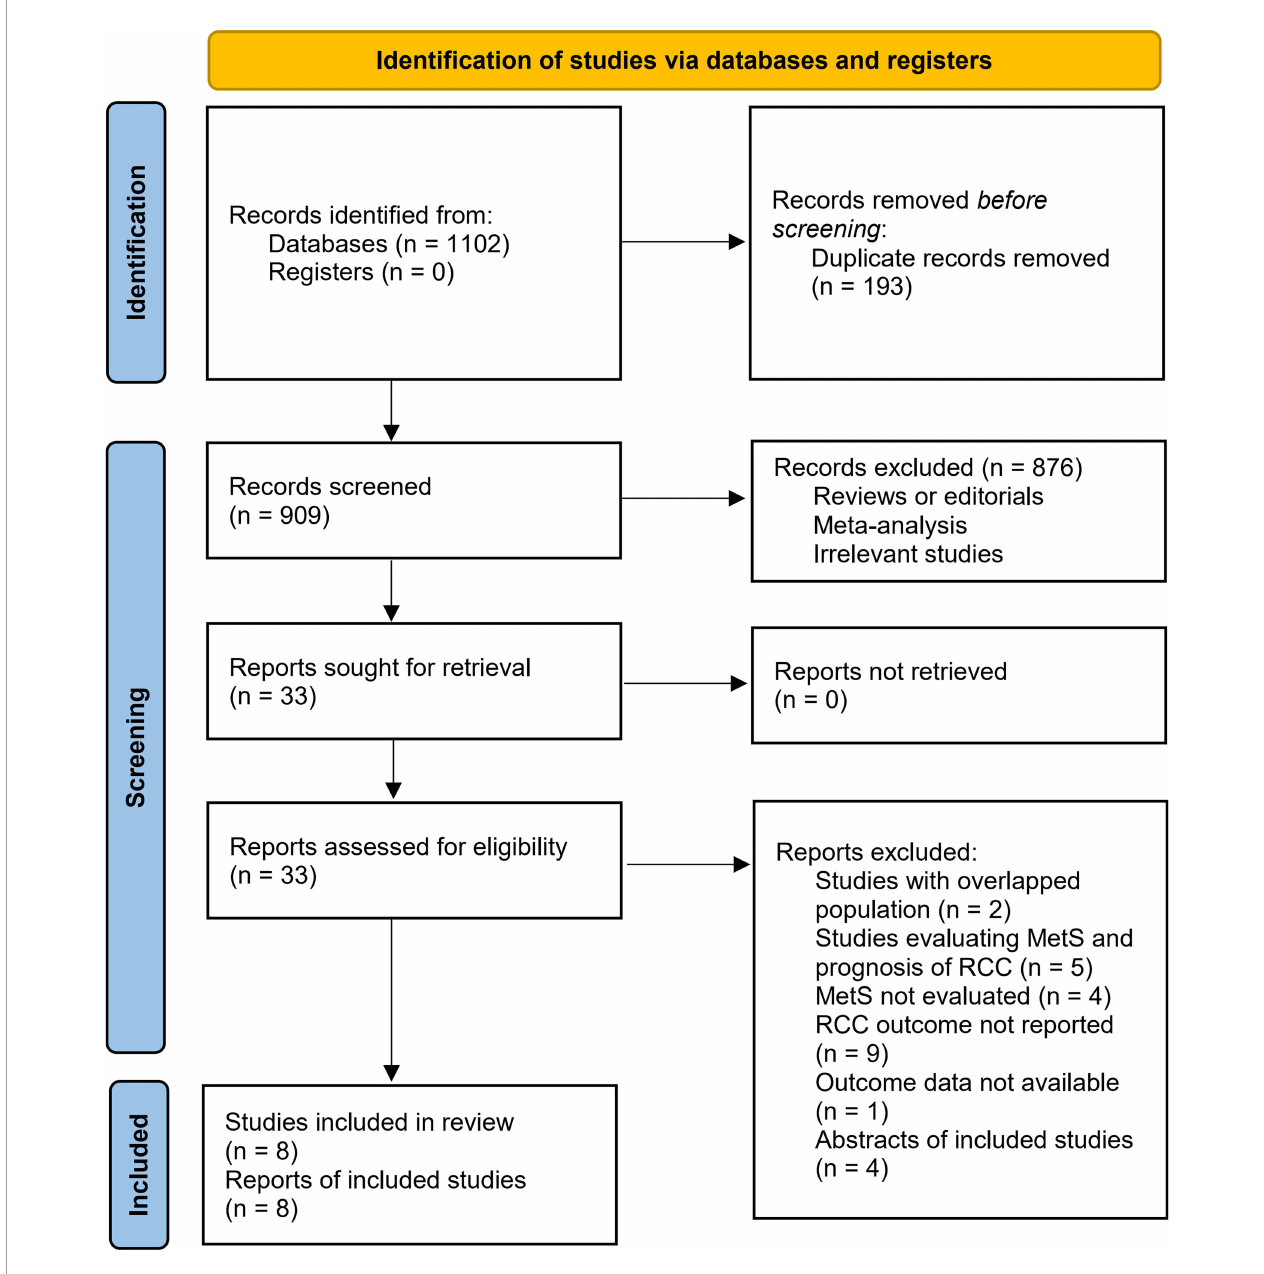
FIGURE 1 | PRISMA diagram of literature search and study